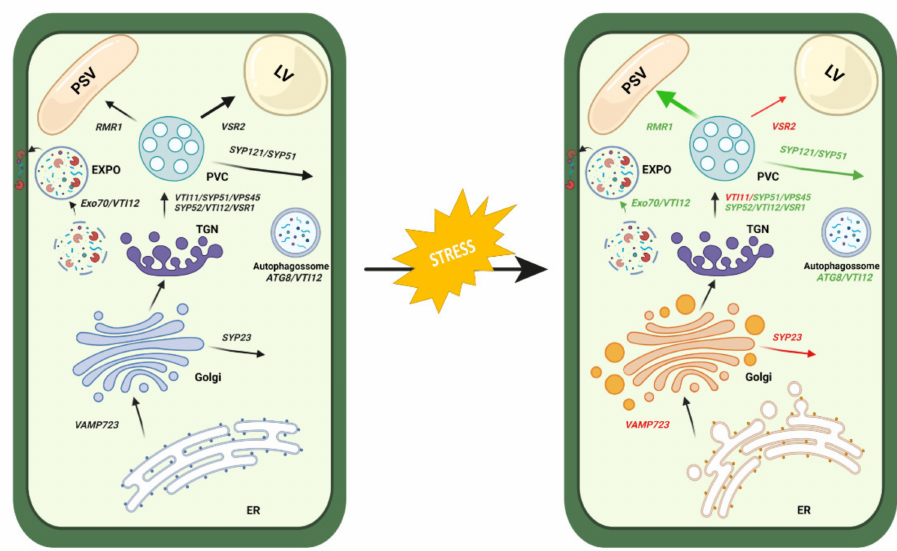
Figure 7. Schematic representation of the plant cell in control versus stress conditions. Left panel — control cell; right panel —cell under stress. The localization of the molecular players analysed in the context of this study is indicated and shown in red or green according to their expression profile (down- or upregulated, respectively). Black arrows represent the different pathways analysed, red arrows indicate downregulated routes and green arrows correspond to upregulated routes. In the right panel, organelles labelled in orange represent the ultrastructural changes observed in relation to control. Image created with BioRender.com, accessed on 28 September